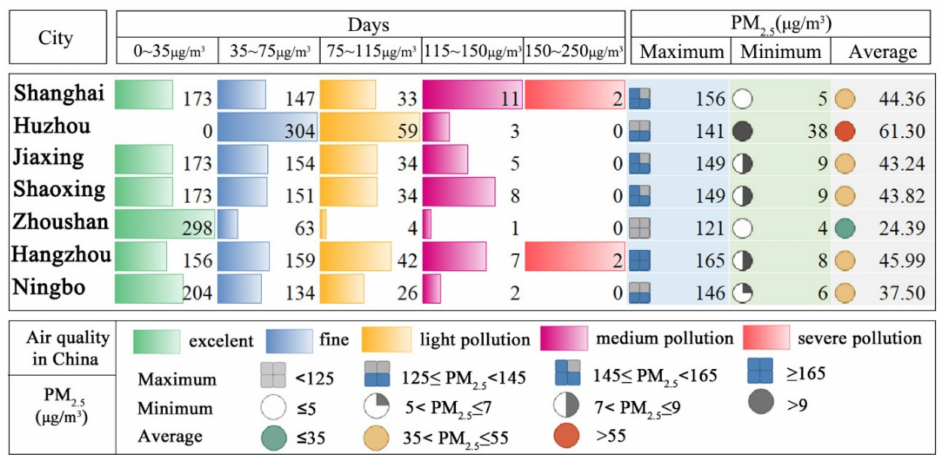
Figure 6. Air quality ratings and observed PM 2.5 concentrations in seven cities. Values for inversion AOD and observation PM 2.5 were processed by the min-max normalization method using a total of 410 groups (Table 6). The monthly correlation analysis results showed inversion AOD had the best correlation with observation PM 2.5 in